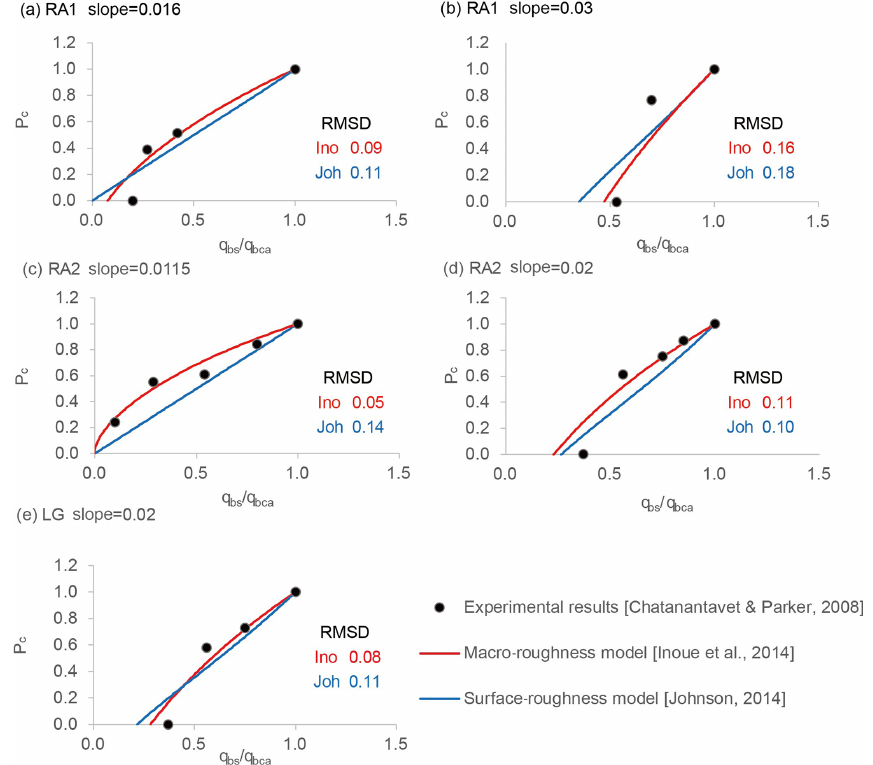
Figure 13. Comparison of the experimental results (Chatanantavet and Parker, 2008) with the macro-roughness model (Inoue et al., 2014) and the surface-roughness model (Johnson, 2014). RA1, RA2 and LG represent the type of bedrock surface in the experiments conducted by Chatanantavet and Parker (2008); RA1 is random abrasion type 1, RA2 is random abrasion type 2 and LG is longitudinal grooves, respectively. The r br for the surface-roughness model and the k sb for macro-roughness model are adjusted to minimize RMSD of the alluvial cover (see Table 3). Representations of (a) runs 2-C1 to 2-C4, (b) runs 2-E1 to 2-E3, (c) runs 3-A1 to 3-A5, (d) runs 3-B1 to 3-B5, and (e) runs 1-B1 to 1-B4 (Chatanantavet and Parker, 2008; Table 1). Table 3. Parameter calibration values for comparison with experimental results of Chatanantavet and Parker (2008) σ br (mm) Adjusted k sb for the Type Slope Observed Adjusted r br for the Calculated k sb in the k sb (mm) macro-roughness surface-roughness surface-roughness model model (mm) (Inoue model k #D = 4 (John- (mm, k sb = r d r br σ br et al., 2014) son, 2014)